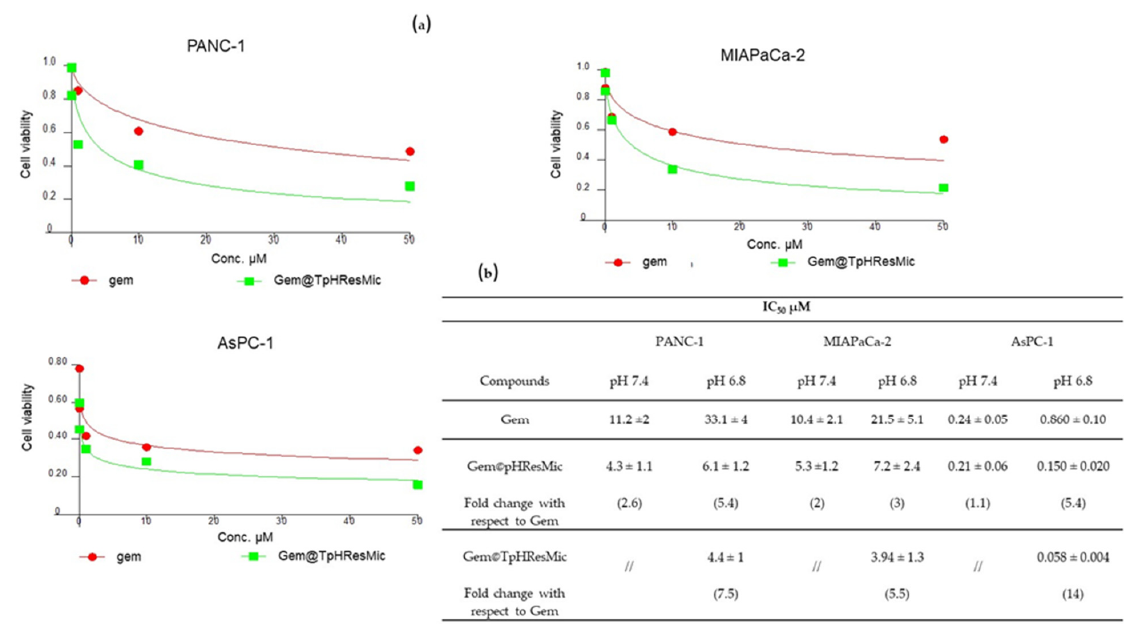
Figure 10. ( a ) Dose/effect plots of the mean of three different cell viability experiments, conducted in PDAC cell lines incubated for 24 h + 48 h w.o. with free Gem or Gem@TpHResMic. ( b ) IC 50 values of PDAC cell lines treated with all treatment conditions; the data are reported as the mean of three independent experiments.